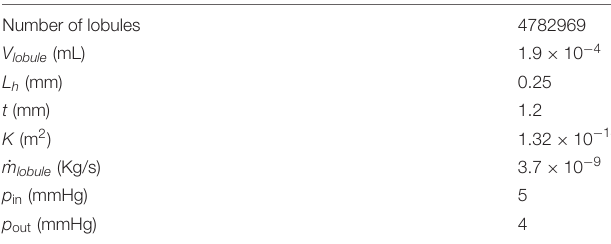
TABLE 3 | Parameters used for the healthy liver lobule.